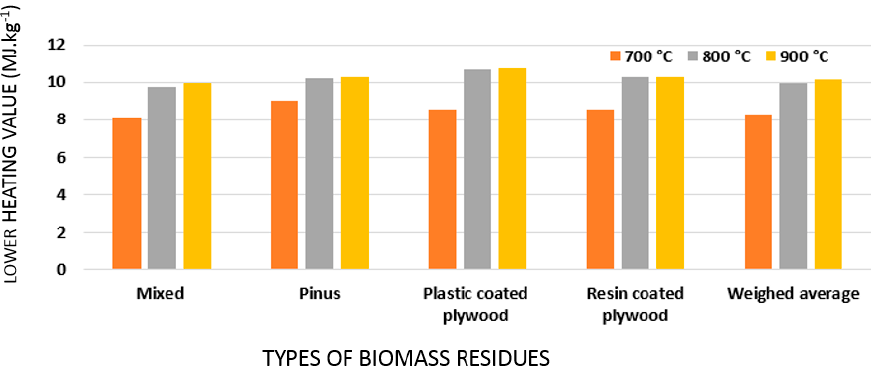
ff ect of the gasification temperature on the LHV of the gaseous Figure 2. Effect of the gasification temperature on the LHV of the gaseous fuels. Figure 2. E